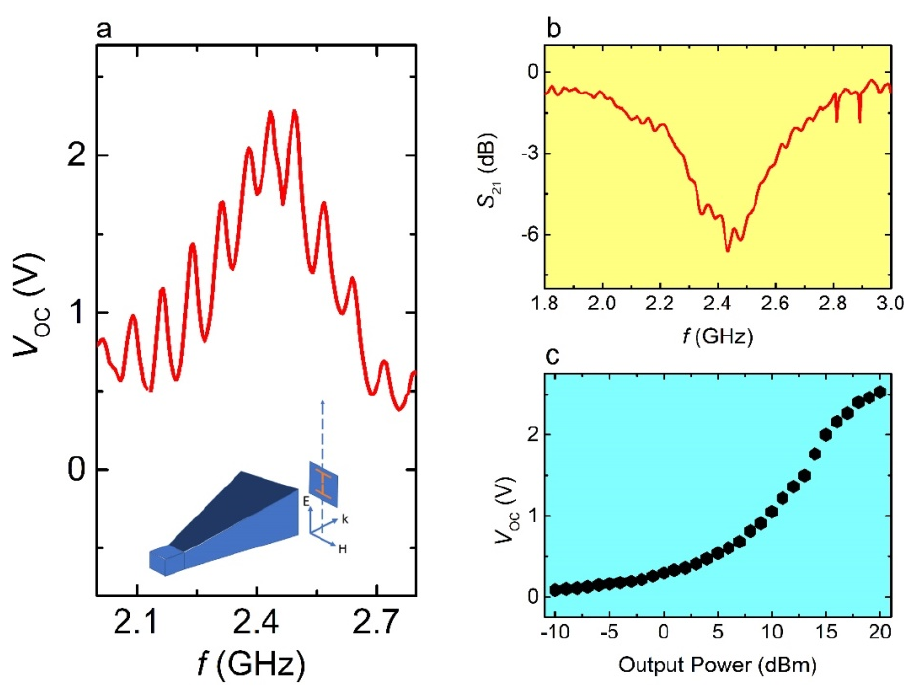
Figure 8. ( a ) Open circuit voltage V OC vs. f, for the Electrifi MS unit. The experimental configuration is shown in the sketch; ( b ) EMI response of the Electrifi MS unit, with diode attached to the MS gap; ( c ) V OC as a function of the horn output power.